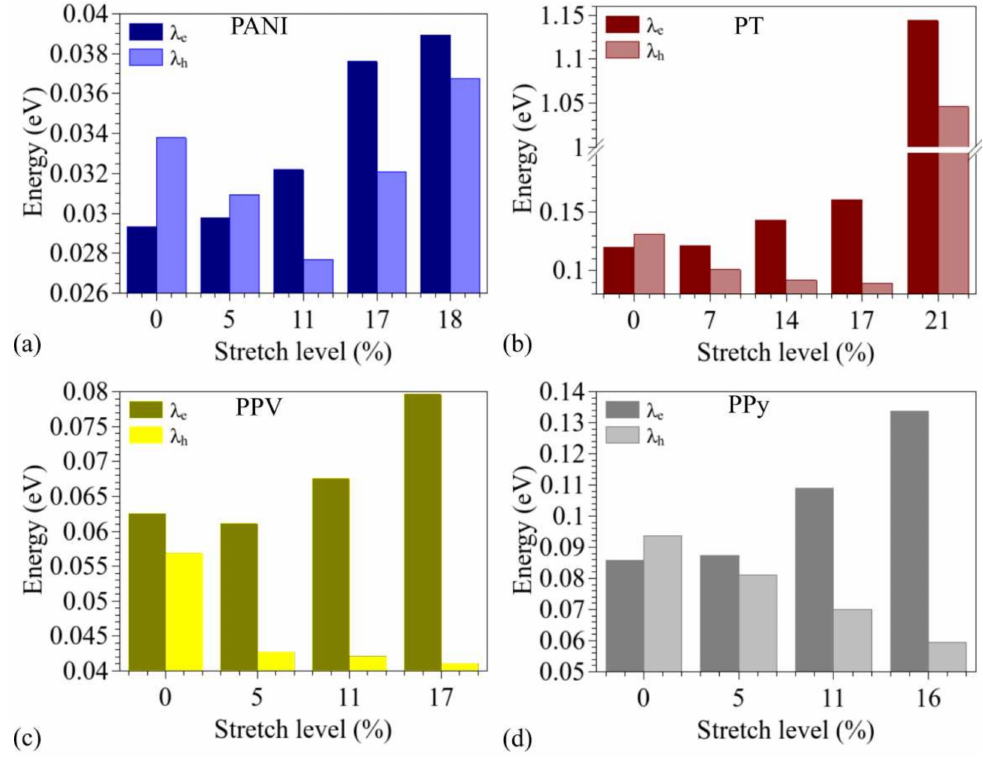
Figure 11. Evolution of the internal reorganization energies during the stretching process: ( a ) PANI, ( b ) PT, ( c ) PPV, and ( d )